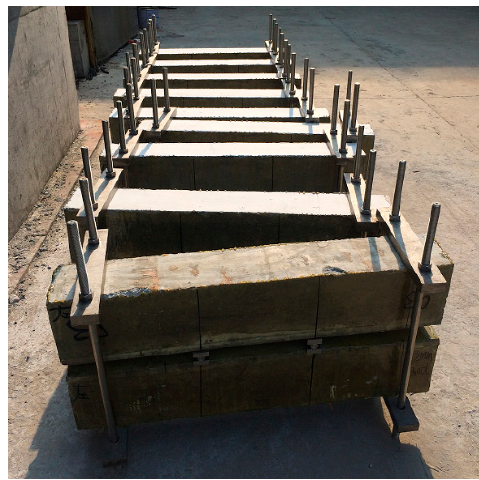
Figure 5. Specimens out of cistern.